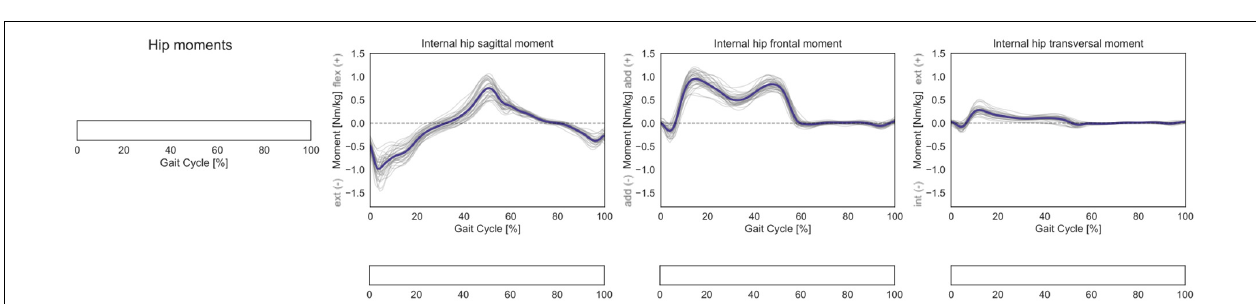
FIGURE 6 | Hip 3D internal net joint moments over the GC. Moments are normalized by body mass. Average profiles for each subject are reported in gray, while the cohort’s mean is reported in dark blue. No statistically significant correlation was observed in the SPM vector-field CCA (leftmost panel), nor in the post hoc scalar-field linear regression analyses (below each kinematic